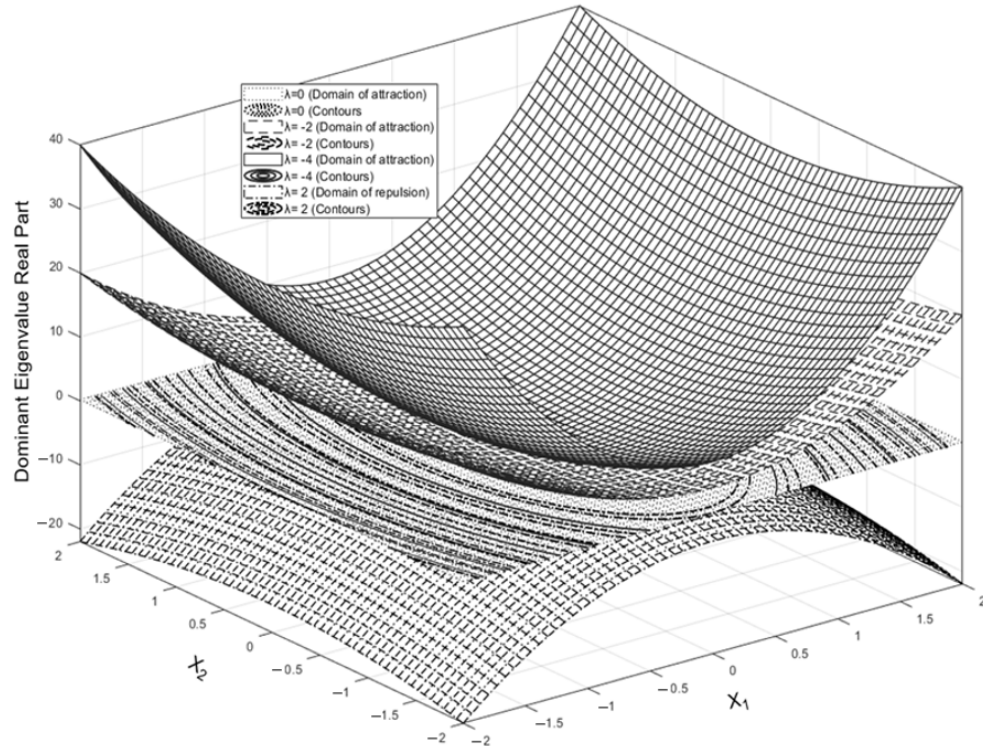
Figure 15. An approximate 3D representation of the equilibrium domain changes due to the system passive control levels. Dominant eigenvalue/pole real part indicate the rate of return to the equilibrium (Case example 1).